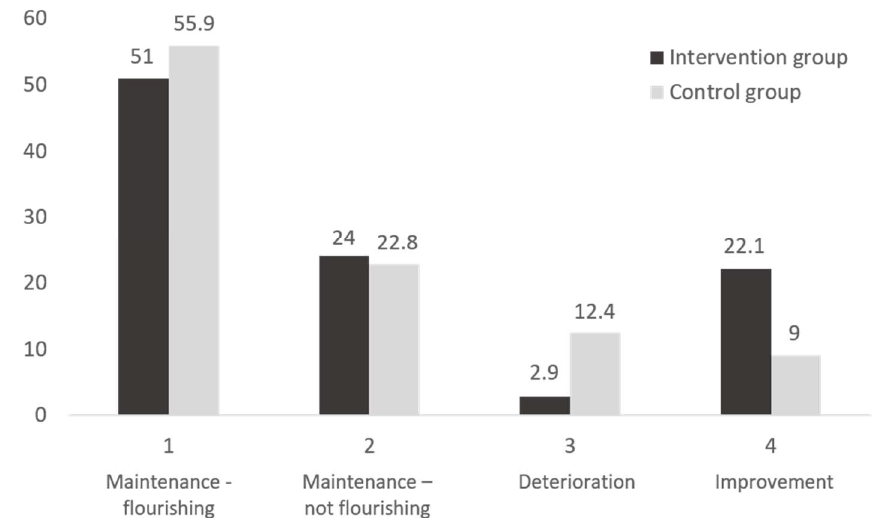
Figure 3. Trajectory of participants in the intervention and control groups from Time 1 to Time 2 regarding category of positive mental health. Maintenance—flourishing: flourishing at both T1 and T2; Maintenance—not flourishing: not flourishing at both T1 and T2; Deterioration: flourishing at T1 and not flourishing at T2; Improvement: not flourishing at T1 and flourishing at T2.